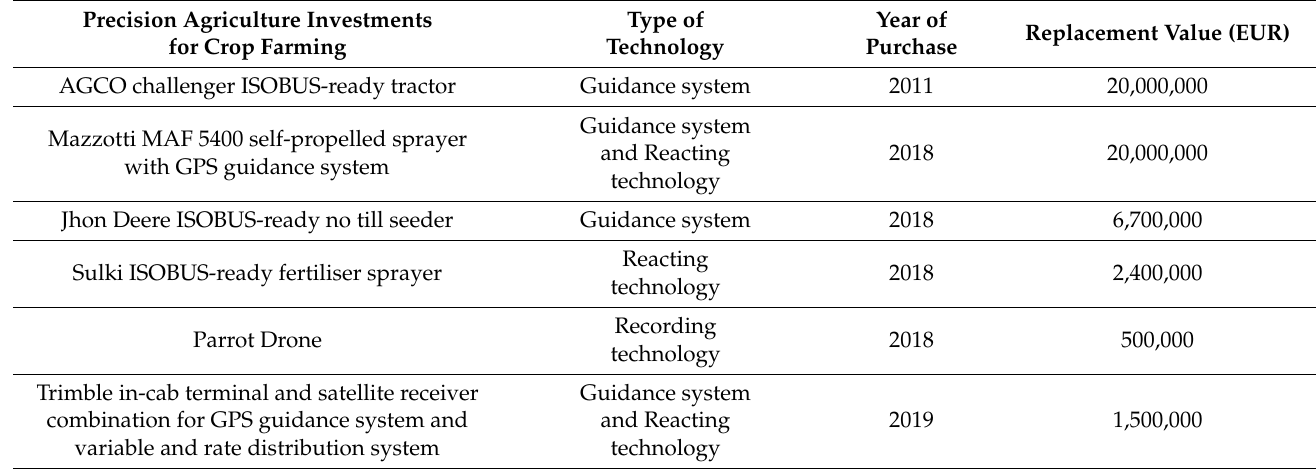
Table 1. Major investments in precision agriculture